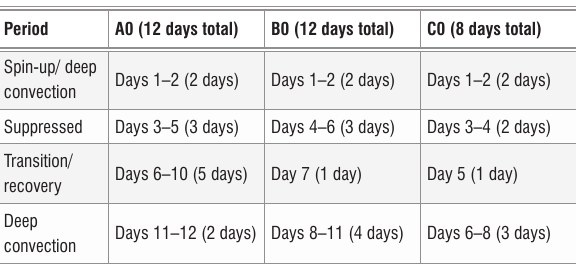
The duration of events expected during the different days sim- ulated for experiments A0, B0 and